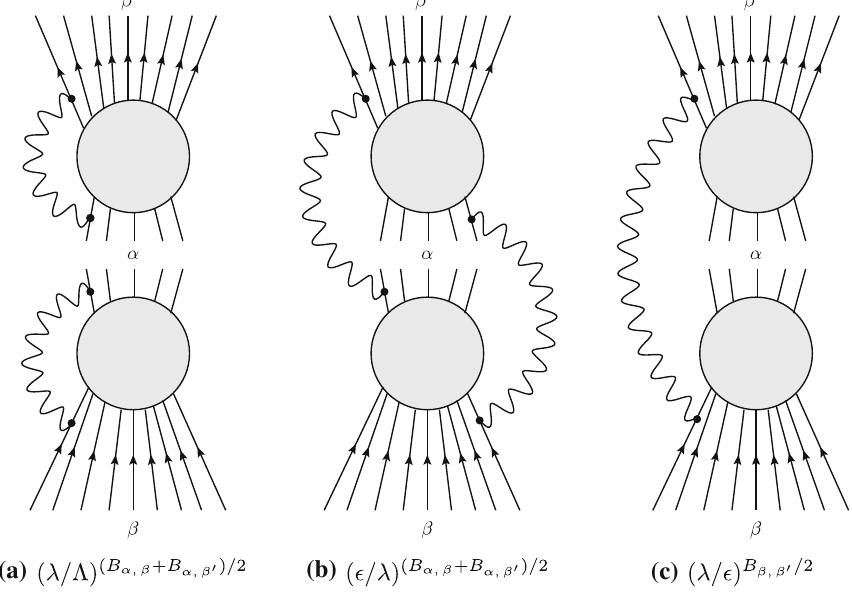
representation of the different contributions to the density (α), dec matrix element ρ ββ (cid:12) . The first contribution is due to soft loops. The second and the third one come from tracing over emitted IR-radiation. The product of the first two contributions gives an IR-finite result, but because of the third one, most off-diagonal elements vanish for λ → 0. The reason is that by tracing over IR-emission in the processes α → β and α → β (cid:12) , we effectively introduce a soft loop from the perspective of the